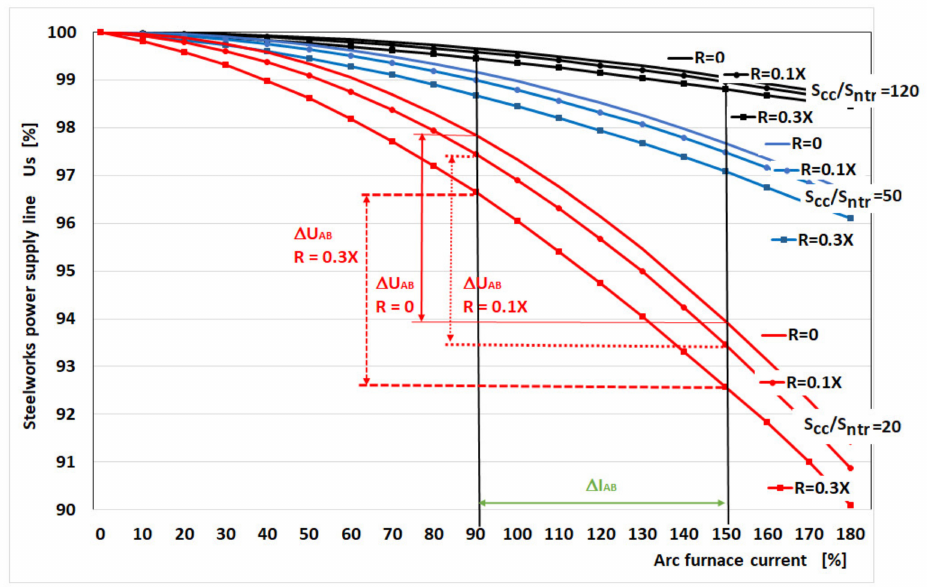
Figure 10. Voltage change as a function of current changes the furnace with the resistance in the power supply circuit of an electric